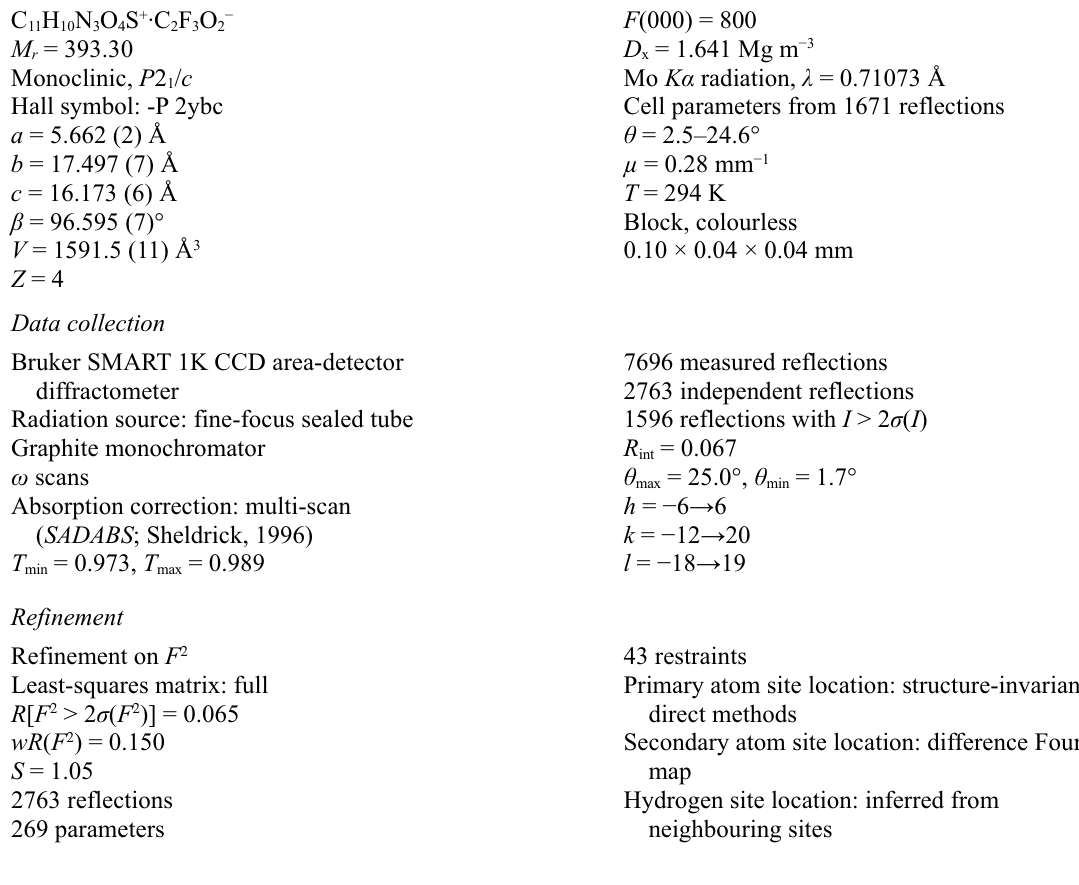
group is shown. 3